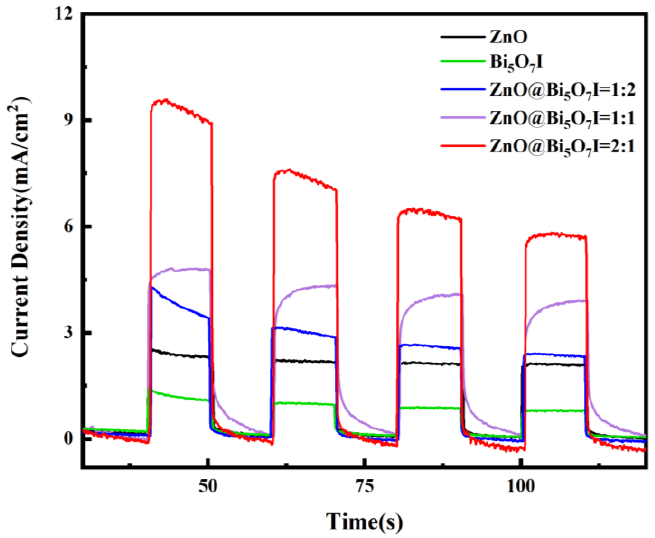
Figure 9. Photocurrent response plots of monomeric and binary complexes.